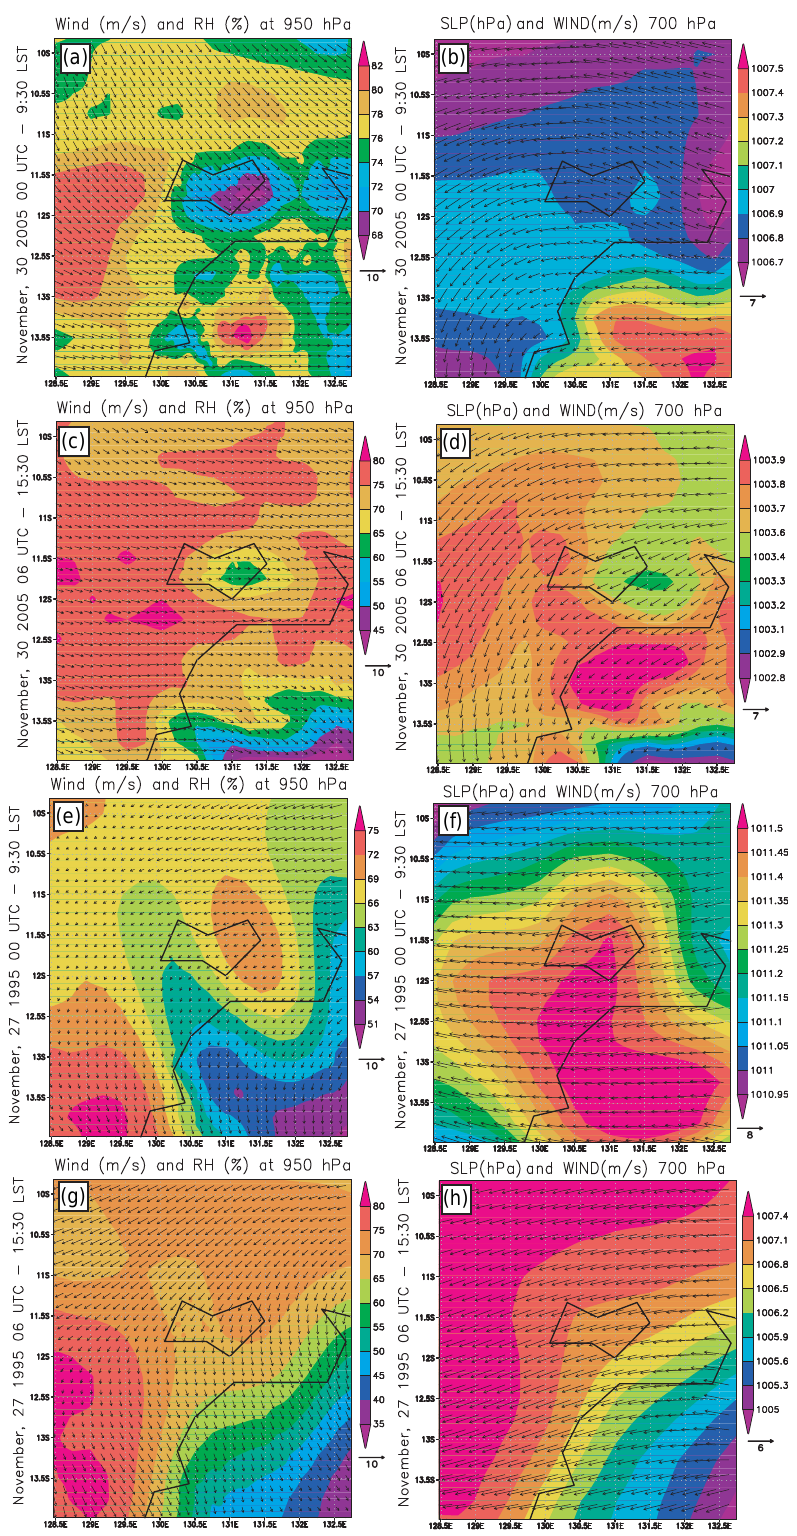
Figure 4. ECMWF analysis over the Tiwi Islands for N30 and N27 at 00:00UTC for the first cell and at 06:00UTC for the second one. Panels (a, c, e, g) report surface wind and relative humidity at 950hPa; panels (b, d, f, h) report sea level pressure in filled contours and wind flow vectors at